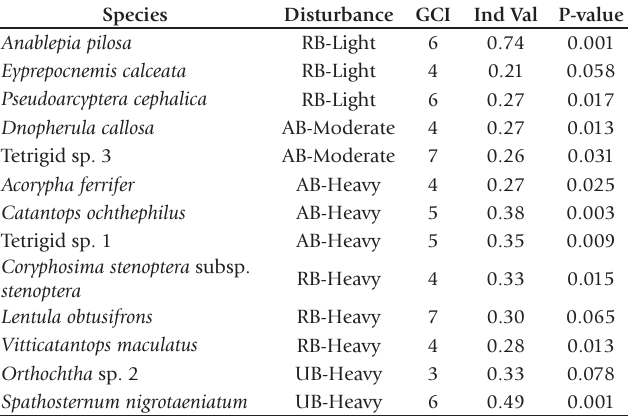
Fig. 3. Canonical analysis of principal coordinates ordination (CAP) of grasshopper assemblage composition to display patterns in the data. Abbreviations for grazing intensity: light in the protected area (square symbols), and moderate (circular symbols) or heavy (tri- angular symbols) in the ecological network. Abbreviations for fire regime: annual burning (AB, solid black symbols), grasslands with longer fire rotation that were recently-burned (RB, solid grey symbols) i.e. burned < 12 months prior to sampling and unburned (UB, open symbols) i.e. burned >12 months prior to sampling. Significance values for pairwise comparisons are in Table 4. Table 5. Indicator species of grazing intensity, fire frequency, and time since last fire. Abbreviations for grazing intensity: light in the protected area, and moderate or heavy in the ecological net- work. Abbreviations for fire regime: annual burning (AB), grass- lands with longer fire rotation that were recently-burned (RB) (i.e. burned <12 months prior to sampling) and unburned (UB) (i.e. burned >12 months prior to sampling). The GCI values of indi- vidual species, Indicator values and P-values were